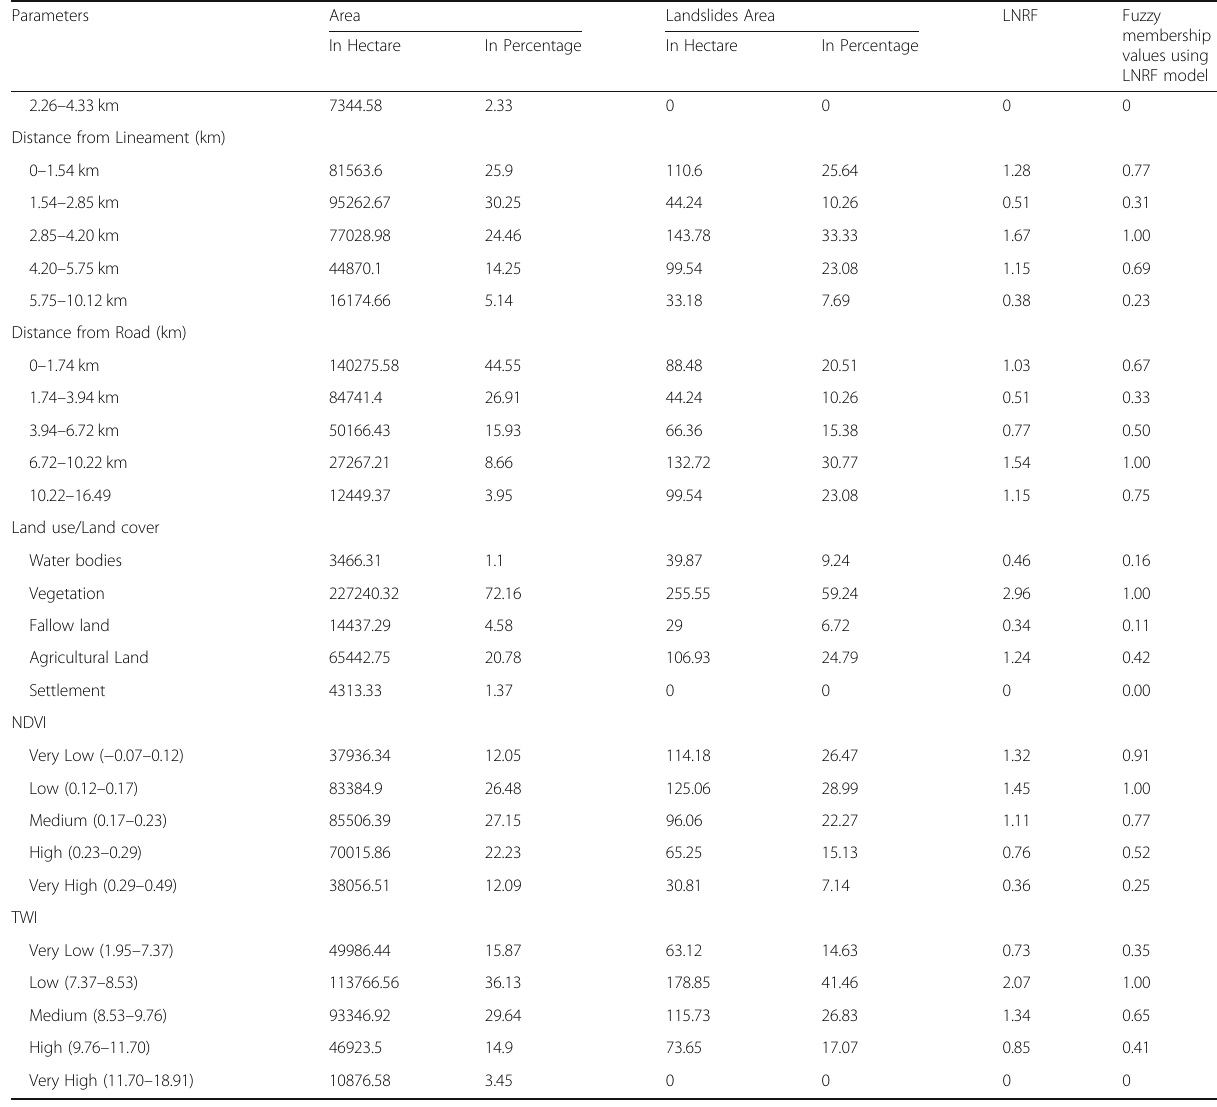
Table 3 Computation of LNRF model on landslide determining Factors (Continued)